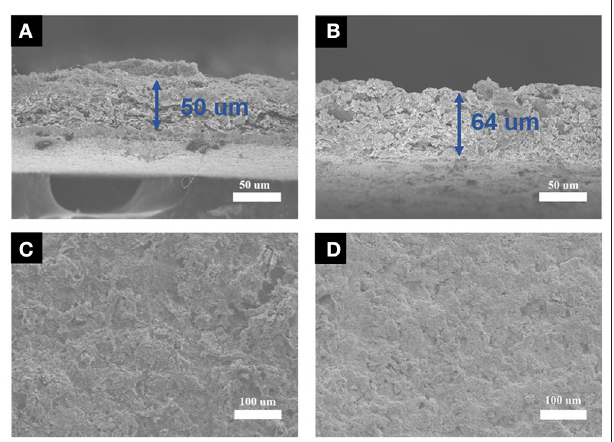
FIGURE 5 | Electrode thickness of Si@rGONSs-2 electrode before cycling (A) and after 100 cycles, (B) SEM images of Si@rGONSs-2 electrode, (C) before cycling, and (D) after 100 cycles.